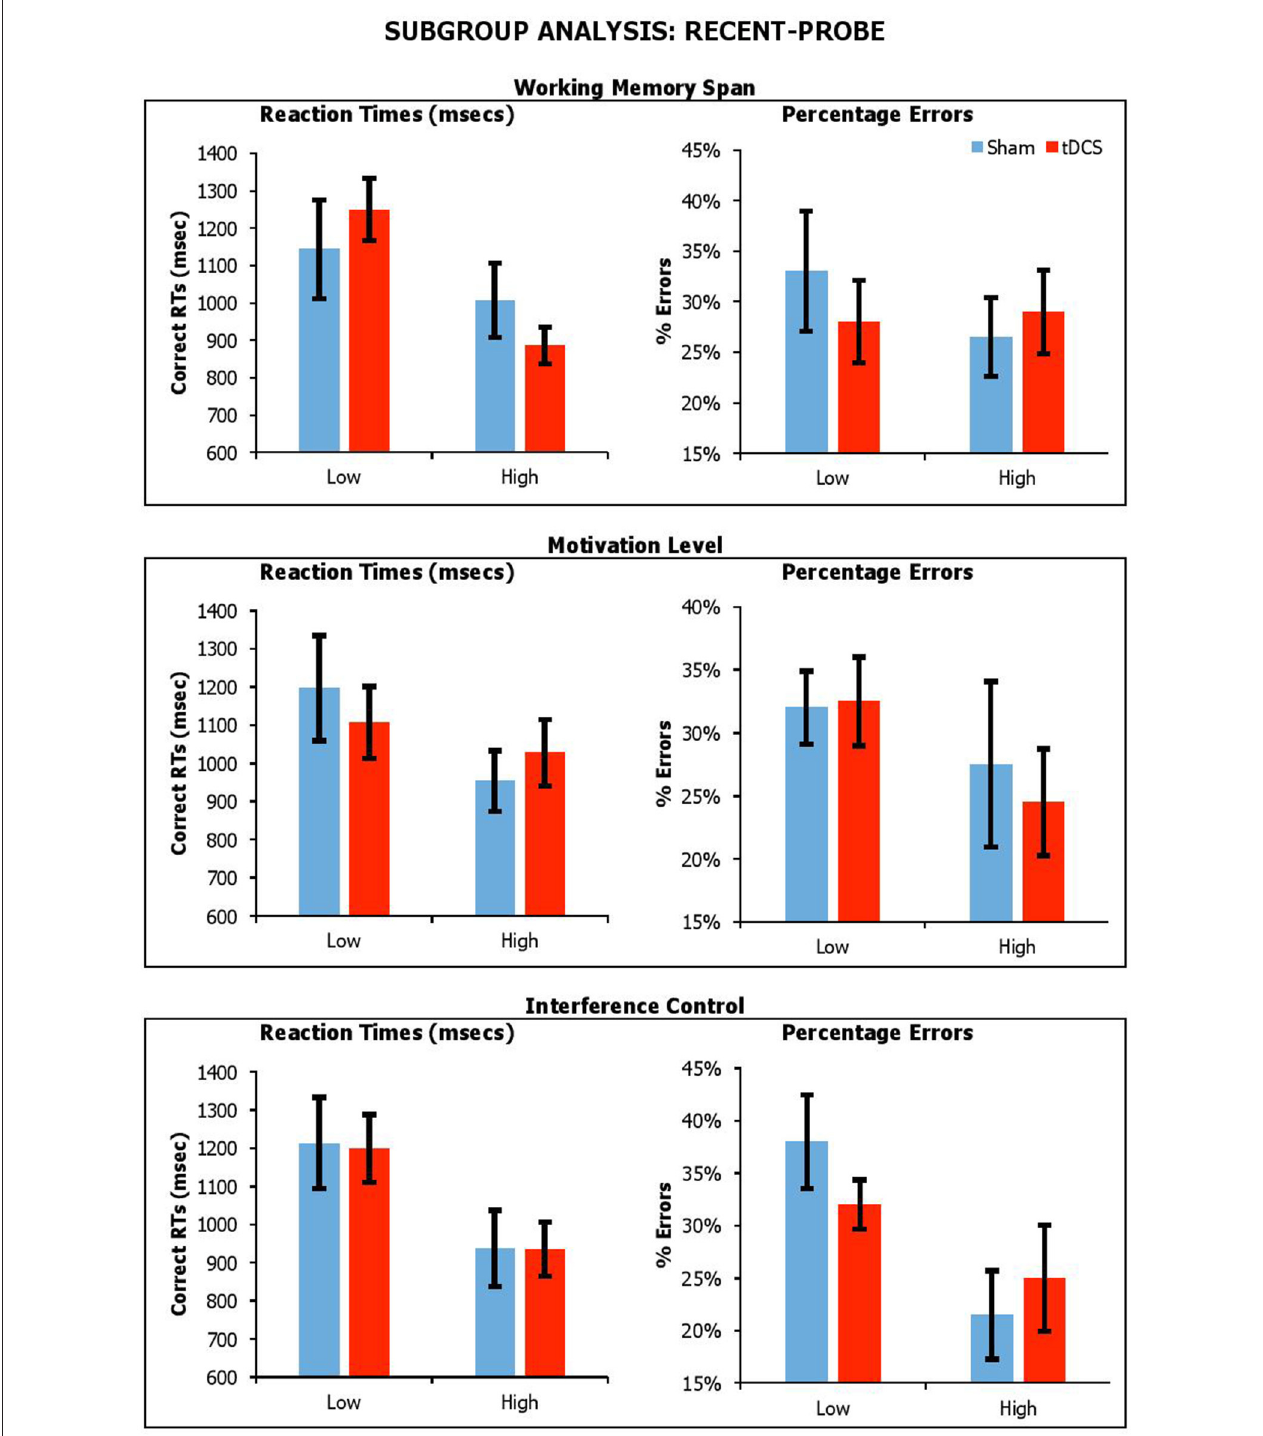
FIGURE 6 | Performance on lure trials (i.e., average of non-recent-negative and recent-negative) in recent-probe across stimulation conditions, with participants divided by Working Memory Span, Motivation Level, and Interference Control. Error Bars indicate Standard Error.